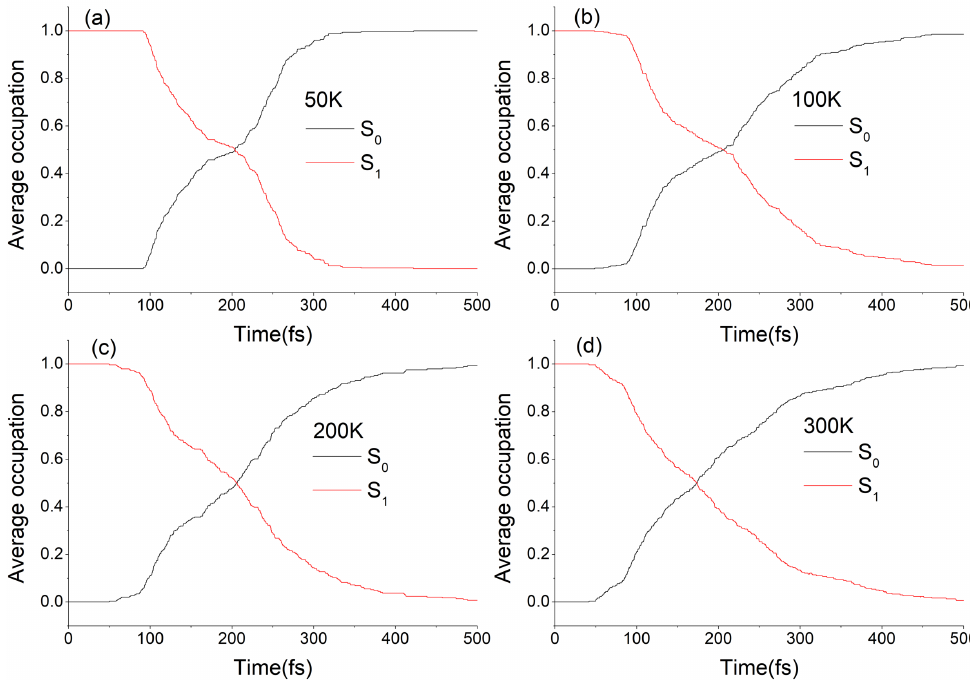
Figure 3. Average occupation of the electronic states S 0 and S 1 as a function of simulation time in